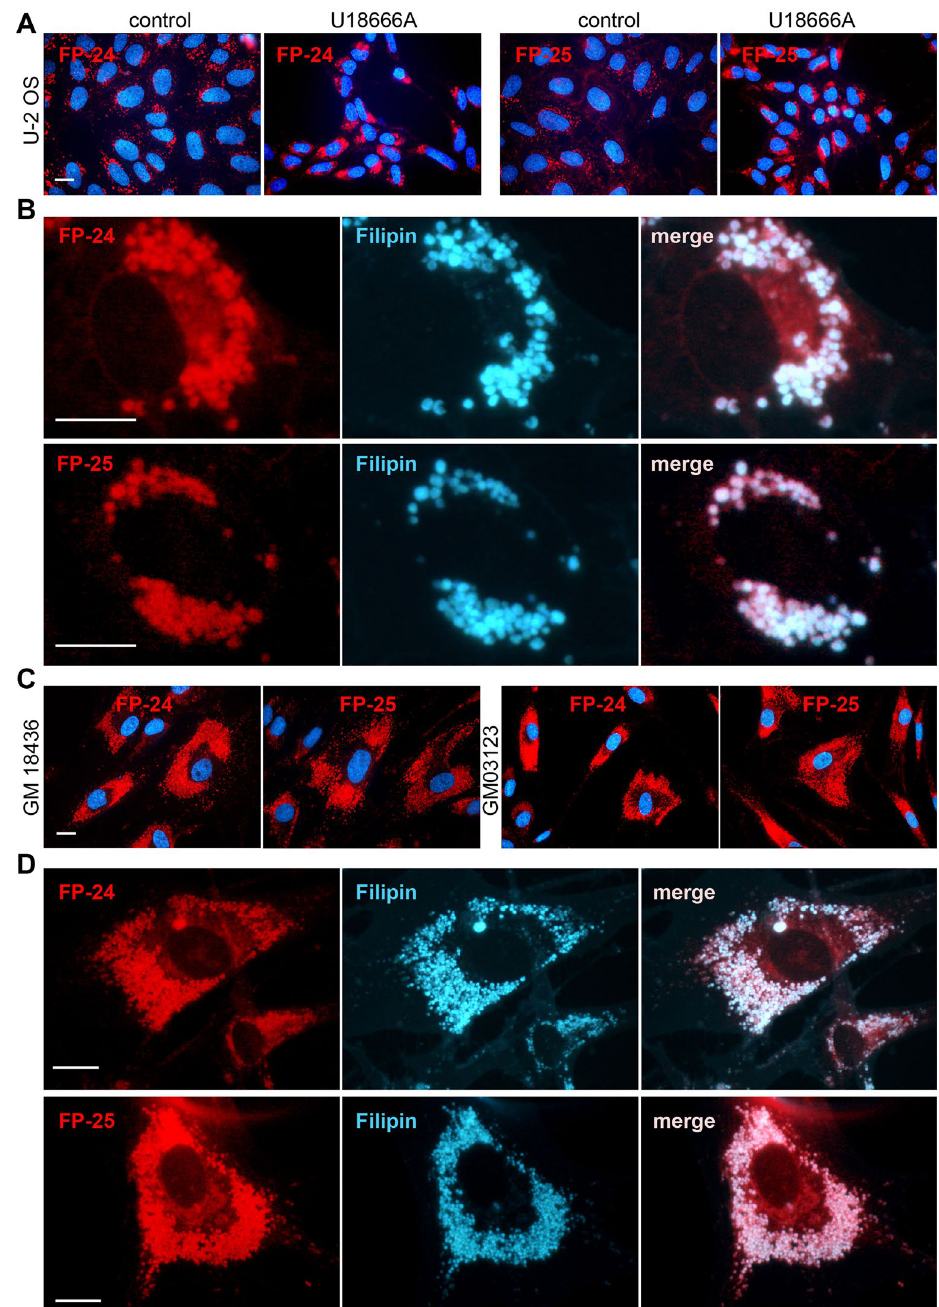
Figure 6. FP-24 and FP-25 fluorescence in cells with abnormal content of cholesterol. ( A ) Cholesterol transport in U-2 OS was inhibited by inhibitor U18666A (1 μg/mL) for 48 h, then cells were labelled with indicated probes (100–200 nM) for an additional 24 h and examined. Control cells were treated with vehicle only. ( B ) Co-localization of FP-24 and FP-25 staining with filipin. U-2 OS cells were treated with inhibitor, labelled with probes, fixed and stained with filipin (50 μg/mL). About 70% of cells displayed significant co-localization of filipin with probe FP-24 (evaluated 107 cells) and 60% with probe FP-25 (evaluated 100 cells). ( C ) Human fibroblasts carrying mutations in NPC1 cholesterol transporter (clones GM03123E, GM18436) were labelled with probes for 20 h and examined. ( D ) Co-localization of FP-5 and filipin staining in mutant cell clone GM18436. About 90% of cells displayed significant co-localization of filipin with probe FP-24 (evaluated 70 cells) and 82% with probe FP-25 (evaluated 60 cells). Scale bars 10